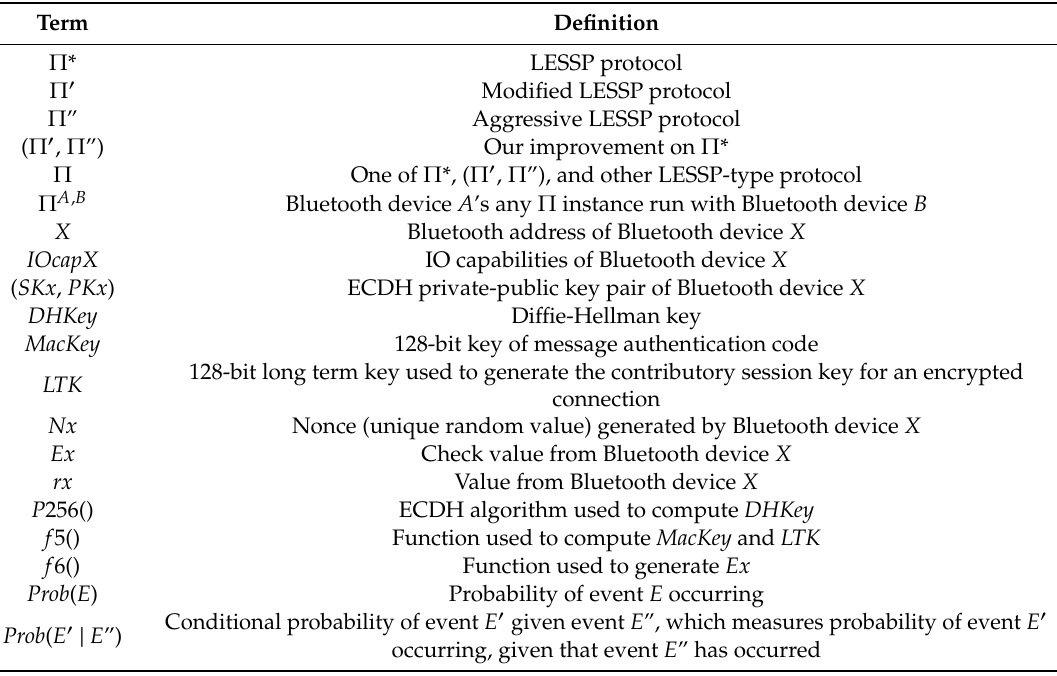
Table 1. Description of